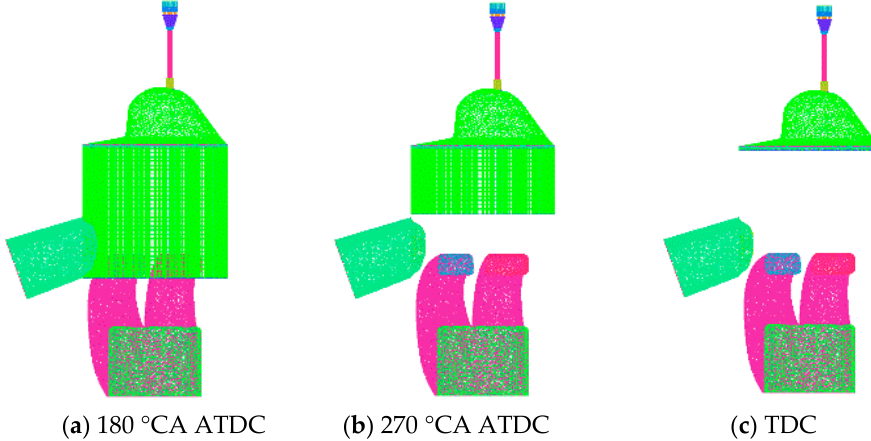
Figure 2. Dynamic meshes of the piston and cylinder wall in the engine fluid domains.